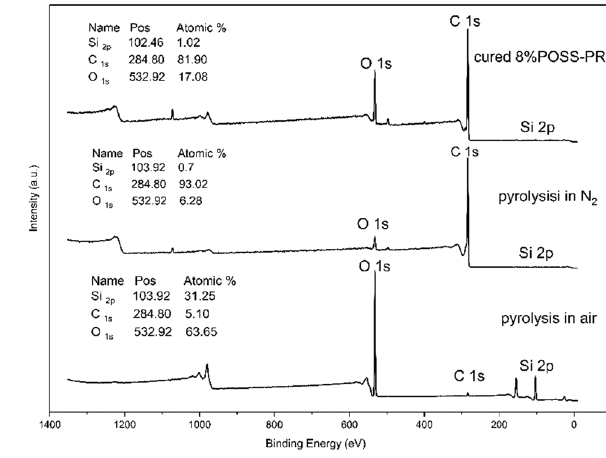
Figure 12: XPS patterns for pyrolysis product of 8% POSS